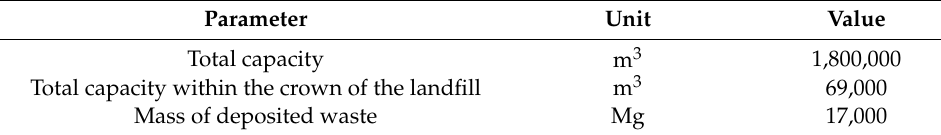
Table 1. Parameters of the reclaimed municipal waste landfill in Kiełcz. Parameter